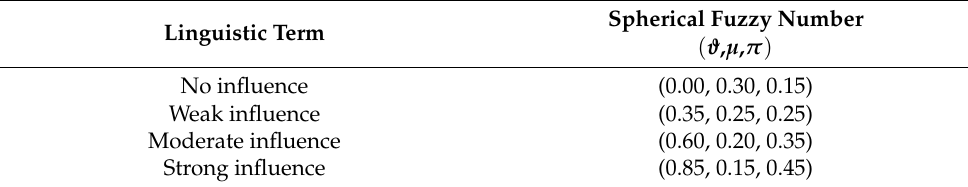
Table 3. Linguistic terms for criteria influence